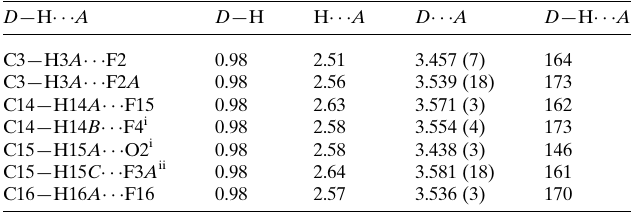
Table 2 Hydrogen-bond geometry (A˚ , (cid:2) ).